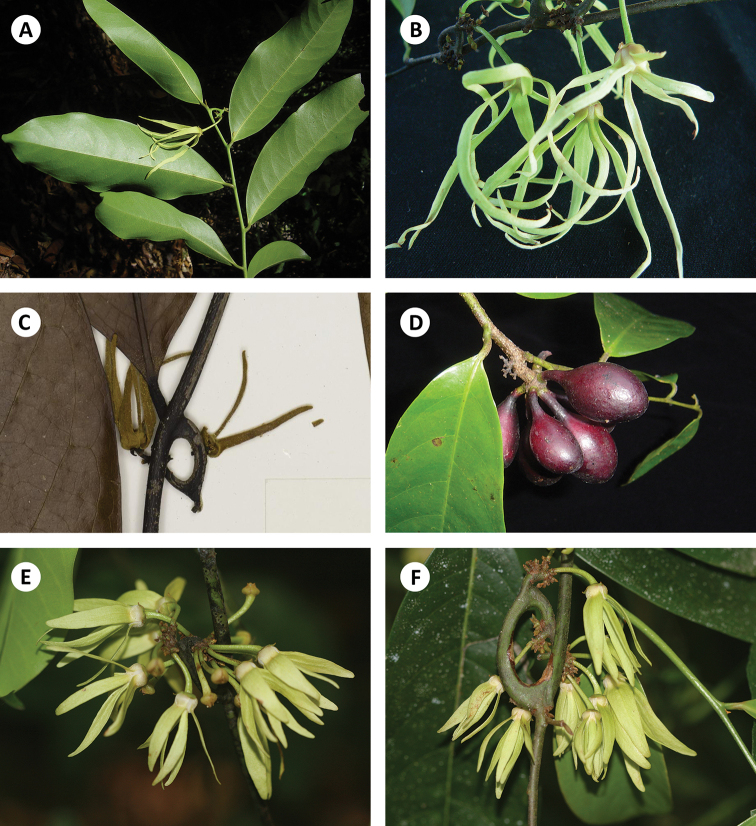
A, BArtabotrys
longipetalus sp. nov. A habit and inflorescence (T. Insura 57) B flowers, showing linear petals with acute apex (T. Insura 57) C, DArtabotrys
tipuliferusC flowers, showing short flower pedicel and linear petals (S. Phusomsaeng 272) D fruit, showing short fruit pedicel and stipitate monocarps (T. Insura 56) E, FArtabotrys
multiflorusE flowers, showing lanceolate petals with acute to obtuse apex F hooked inflorescence with many flowers. Photos: A, B, D T. Insura C Royal Botanic Garden Edinburgh E, F P. Chalermglin.